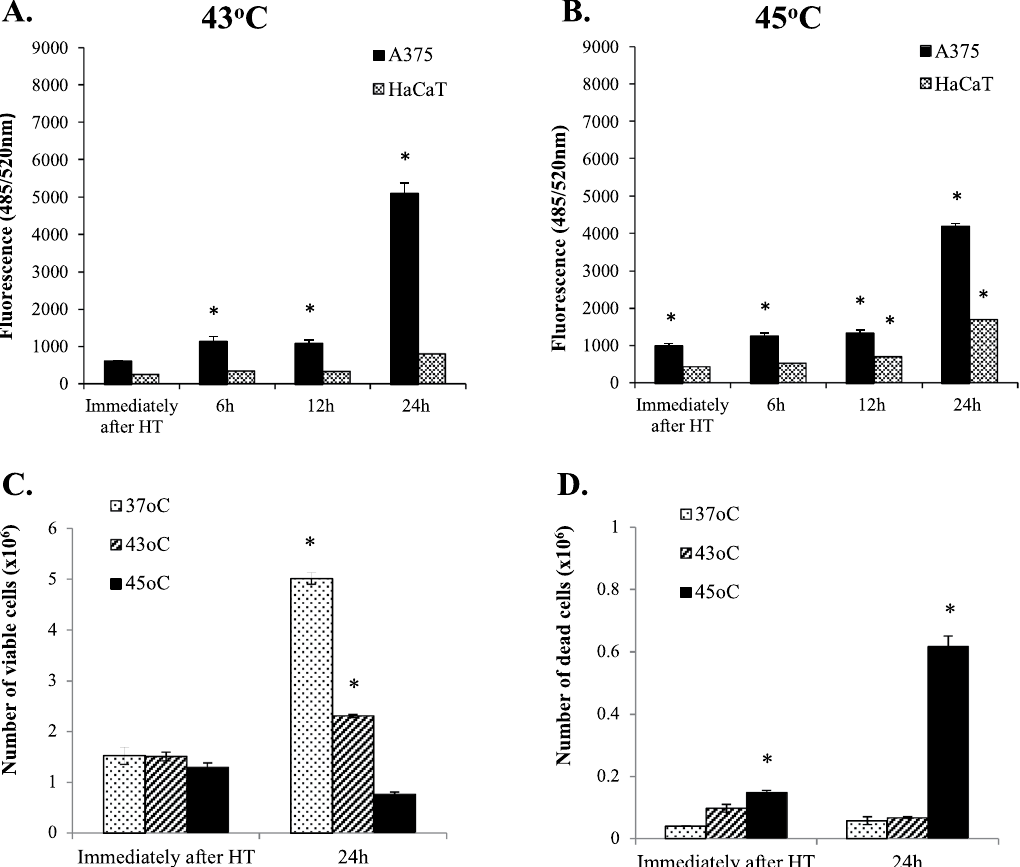
Figure 2. Hyperthermia-induced cytotoxicity in human immortalized keratinocyte (HaCaT) and malignant melanoma (A375) cell lines. The effect of hyperthermia at ( A ) 43 °C and ( B ) 45 °C was expressed as fluorescence values indicative of relative levels of dead cells in A375 and HaCaT cells; The effect of hyperthermia on levels of ( C ) cell viability and ( D ) dead cells was determined by trypan blue staining in A375 cells. Data shown are mean values (n = 5) ± SEM and represent one of three independent experiments. Asterisk ( * ) indicates statistical significance at p <